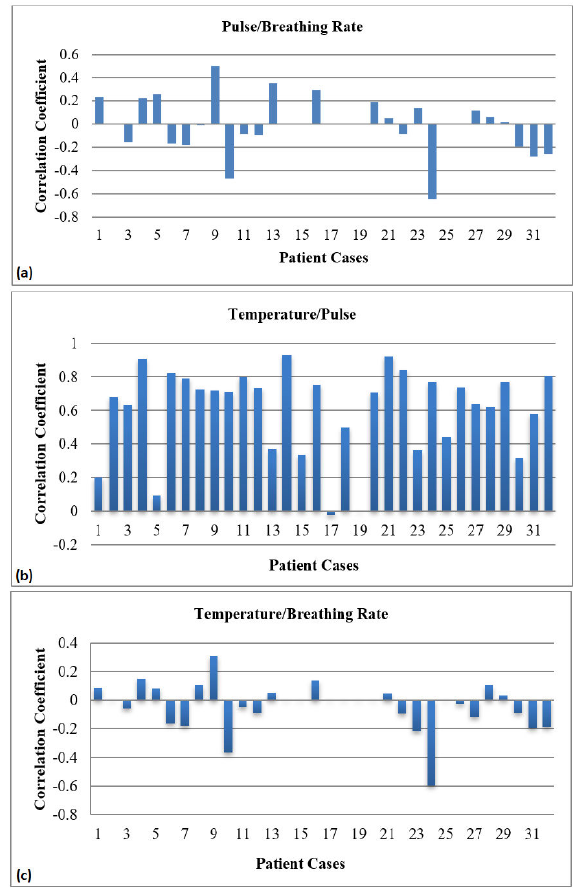
Figure 2. (a), (b), (c):Correlation Results of Vital Signs for Sepsis Disease